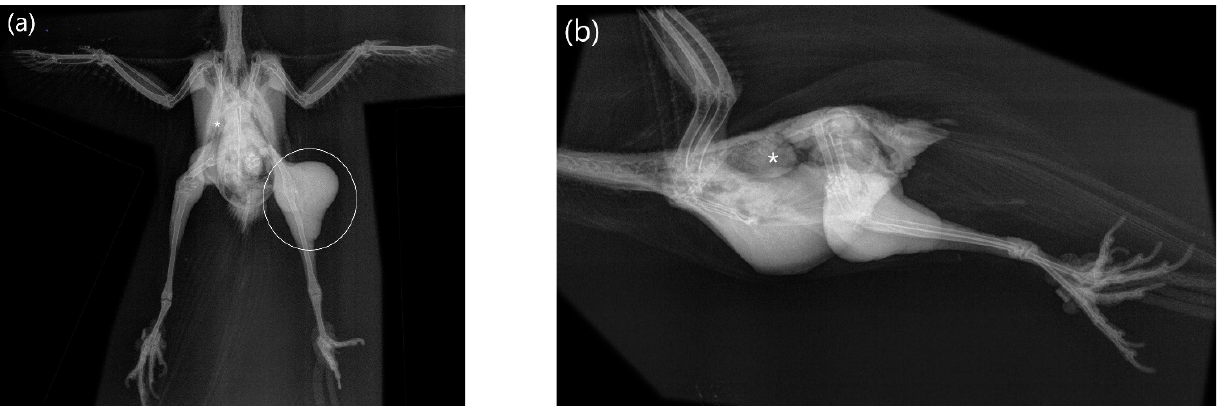
Figure 2. Total body radiographs of a red-crowned parakeet ( Cyanoramphus novaezelandiae ) labelled as case no. 1.: ( a ) Ventrodorsal projection with soft tissue shadowing of both knees, more pronounced on the left knee (white circle), with irregular decreased bone density and multiple osteolytic defects of the right distal femur and a round soft tissue shadowing within the right thoracic region, possibly associated with the right lung (white asterisk); ( b ) Latero-lateral projection with a soft tissue shadowing on the caudal edge of the lung (white asterisk).